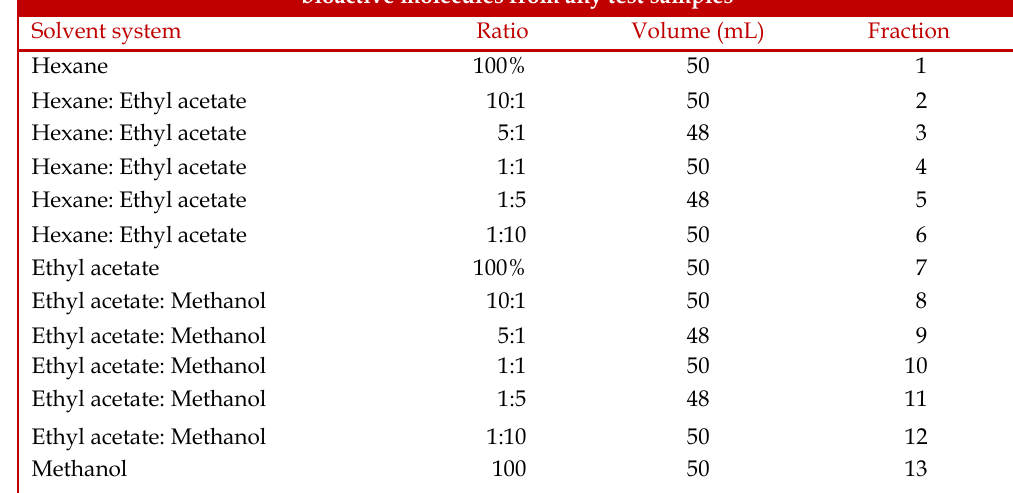
Gradient solvent system to be used in the column-chromatography for the isolation of bioactive molecules from any test